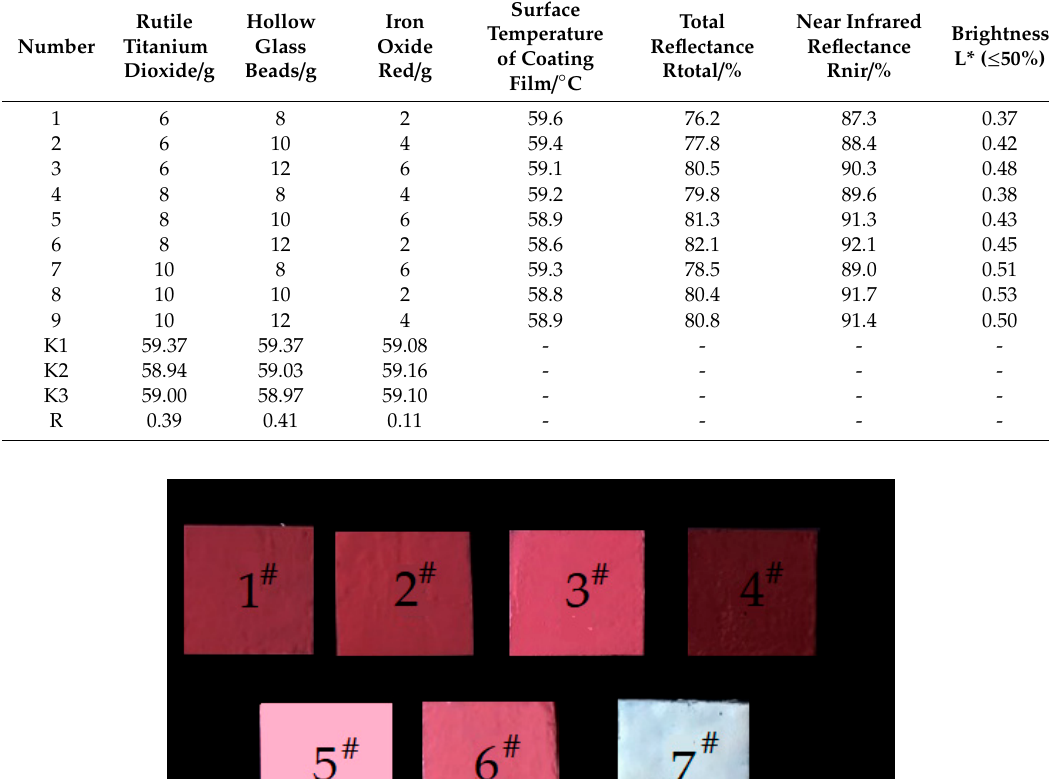
Table 2. Orthogonal experimental scheme of the coating filler formula and coating performance.